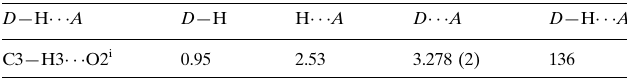
Hydrogen-bond geometry (A˚ , (cid:1)